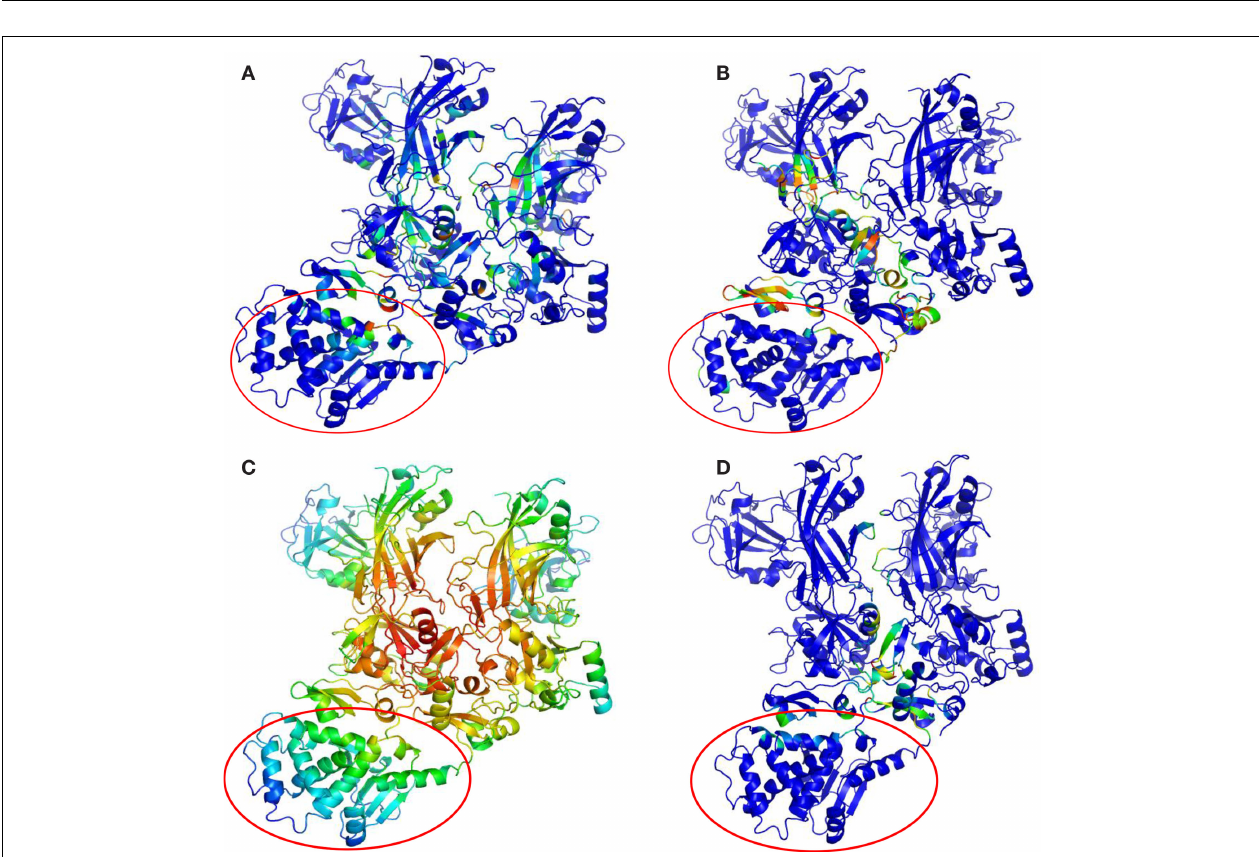
FIGURE 4 | Maps of PCN descriptors on protein structures: complex PA–PA–LF (PDB: 3KWV): (A) betweenness centrality; (B) participation coefficient P ; (C) closeness centrality; (D) inter-chain degree . The lethal factor (LF) is highlighted by the empty circle.